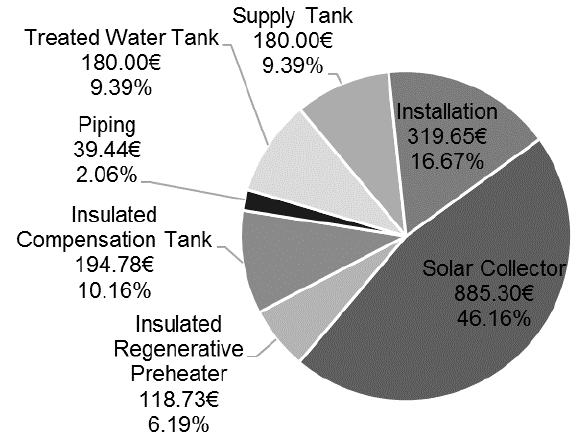
Figure 7. Purchase and installation costs considered and their percentage values on the total investment cost.